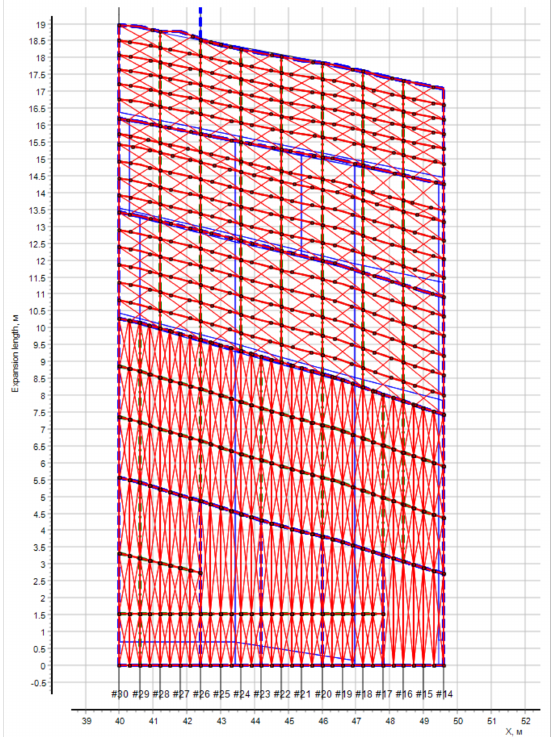
Figure 14. The result of EPPs identification for side structures (307 EPPs, 3.8 s required). In this Figure the blue lines are the borders of the plates, red crosshairs—detected